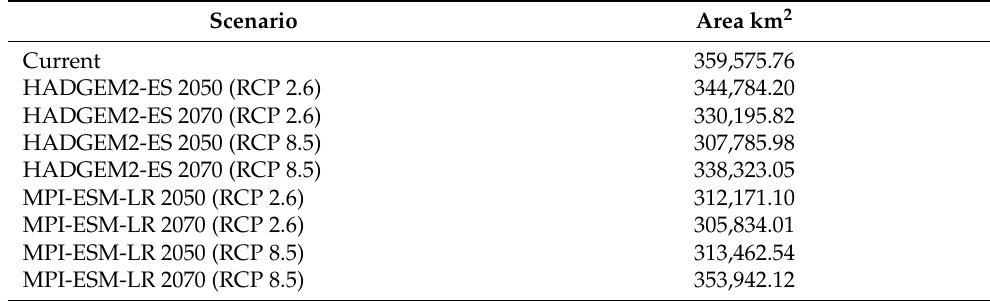
Table 2. Optimum suitable area for fig cultivation under current and climate change scenarios.